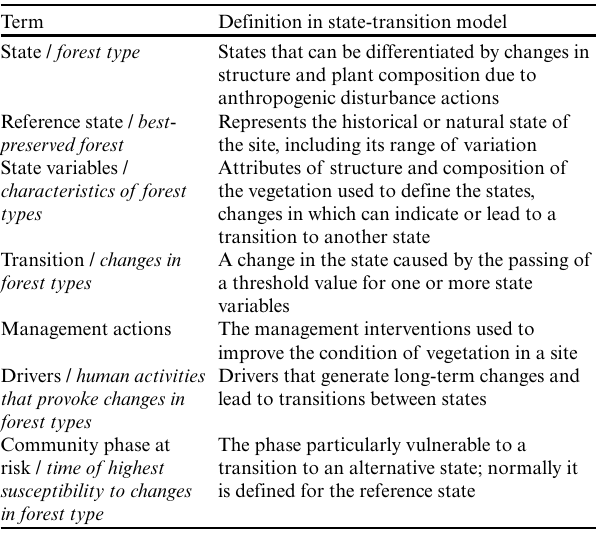
Table 1. Brief description of the key terms used in this study. Terms were adapted from Bestelmeyer et al. (2010, 2017) and Rumpff et al. (2011). Alternative, nontechnical terms used with locals are indicated in italic